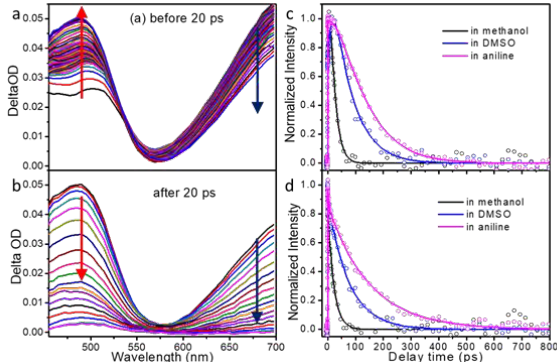
Fig. 1. Time resolved spectra of HPS in DMSO. (a) before 20 ps; (b) after 20 ps. The experimental (dotted lines) and fitted (solid lines) data are normalized decay curves of the two absorption bands at (c) 480 nm and (d) 665 nm,